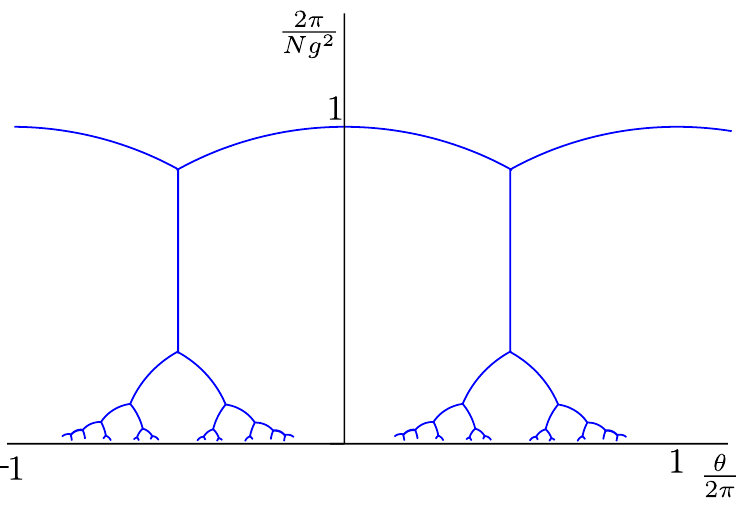
+ i 2 π . We here draw the 2 π Ng 2